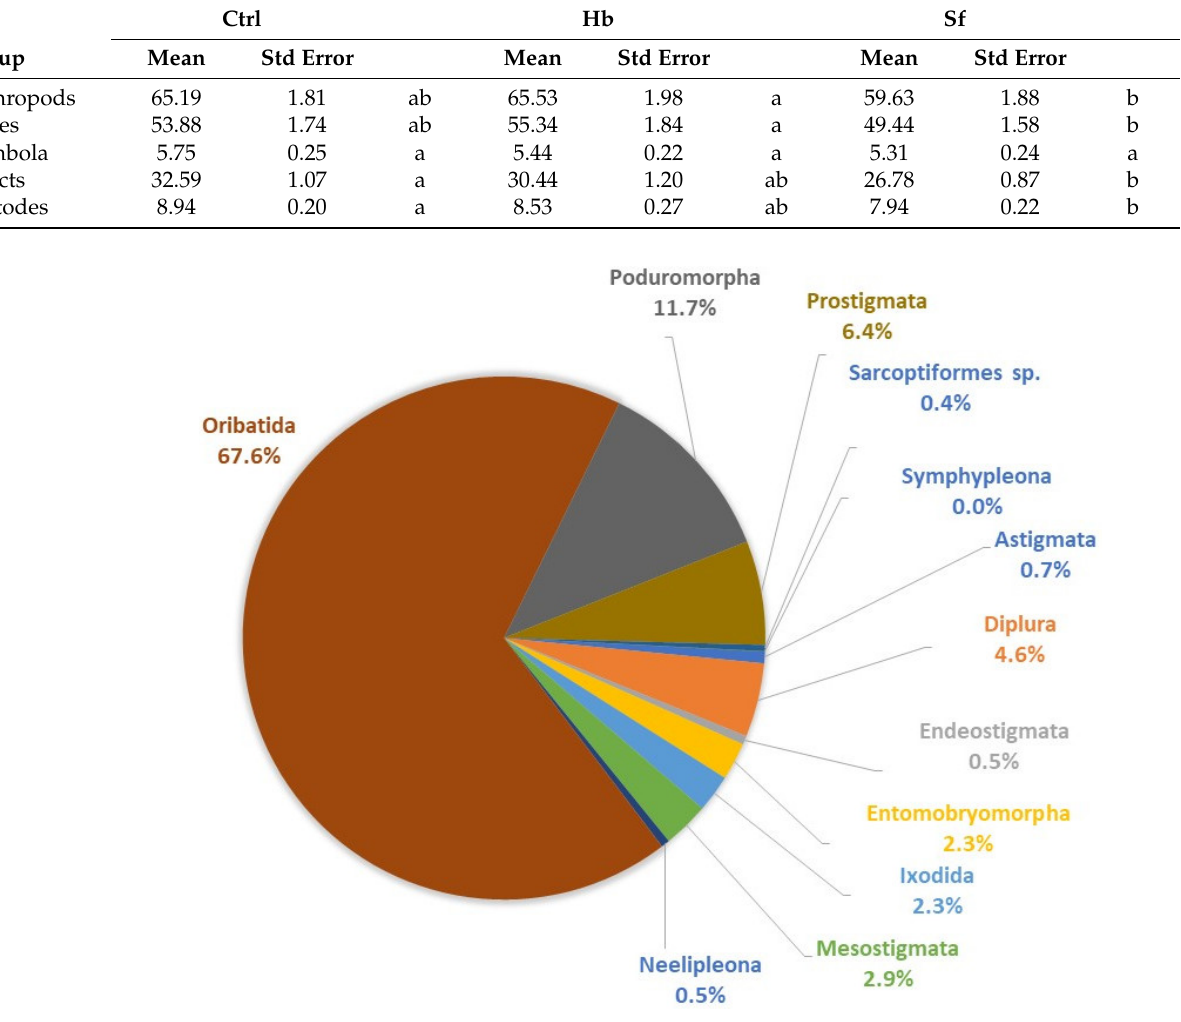
Figure 4. Pie chart of proportional composition of major microarthropod groups recovered from high-throughput sequencing of DNA recovered from soil in a citrus orchard for 28 days following augmentation of two EPN species or no augmentation. Table 2. Motu richness ( R ) of major taxa in the plots augmented with Heterorhabditis bacteriophora (Hb), Steinernema feltiae (Sf) and the untreated controls (Ctrl). Means in rows with the same letters do not differ ( p < 0.05).